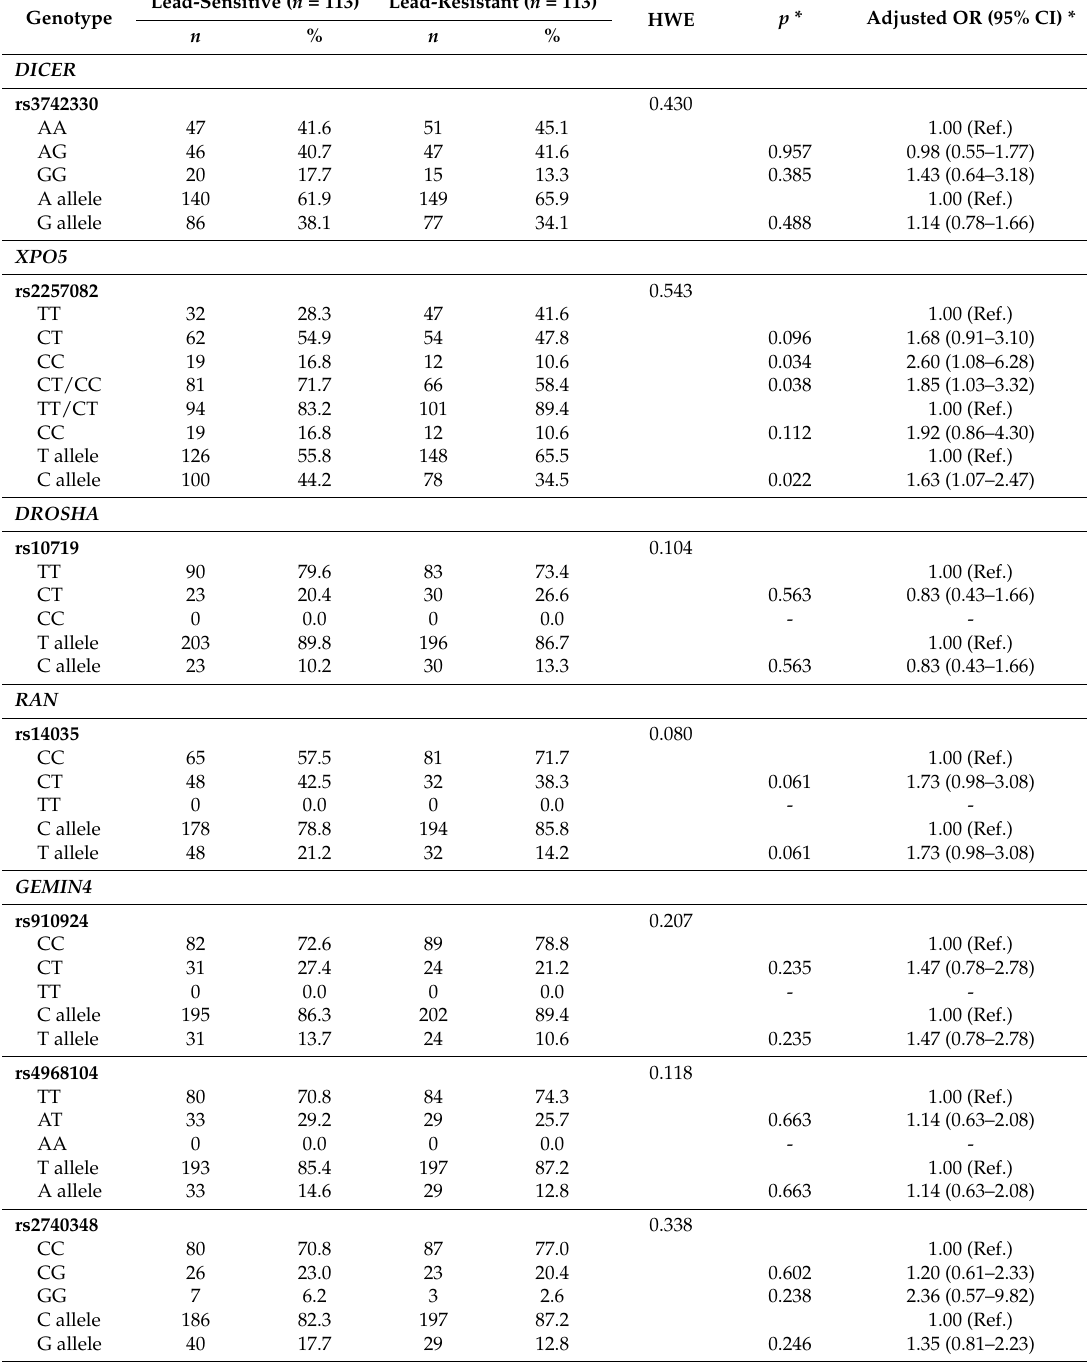
Table 2. Genotype frequencies of miR-SNPs in lead-sensitive and lead-resistant participants.